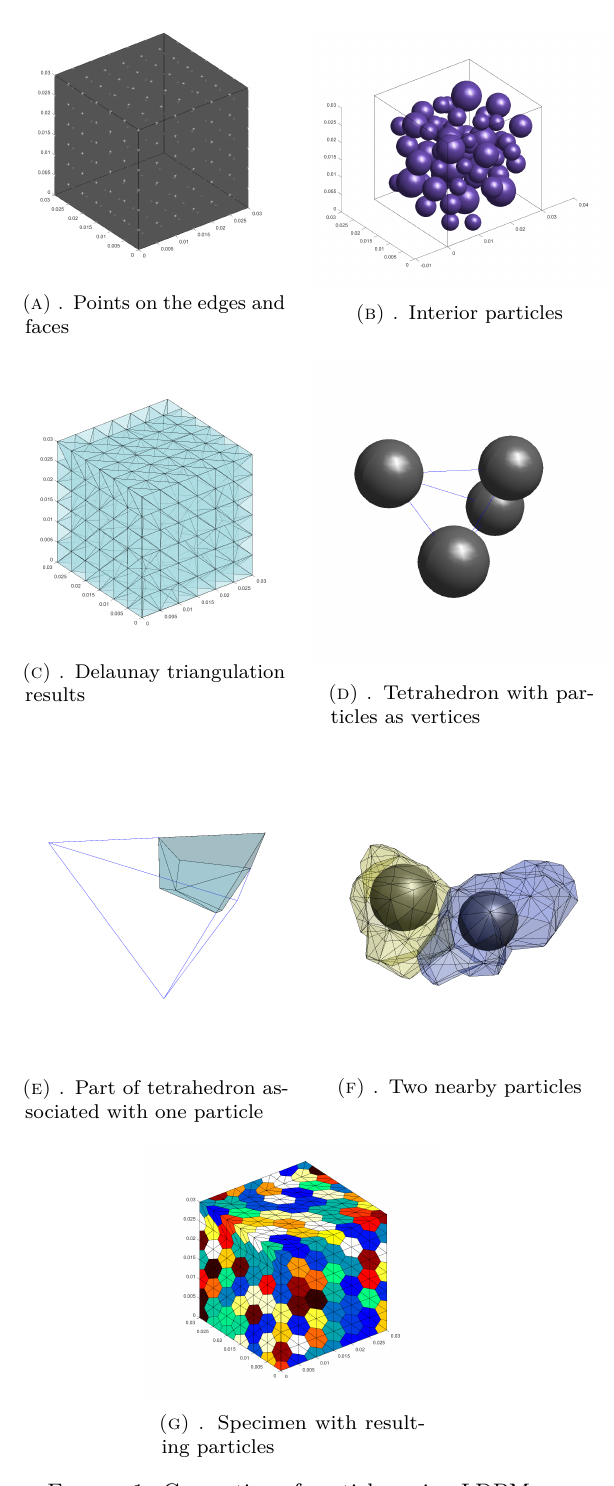
Figure 1. Generation of particles using